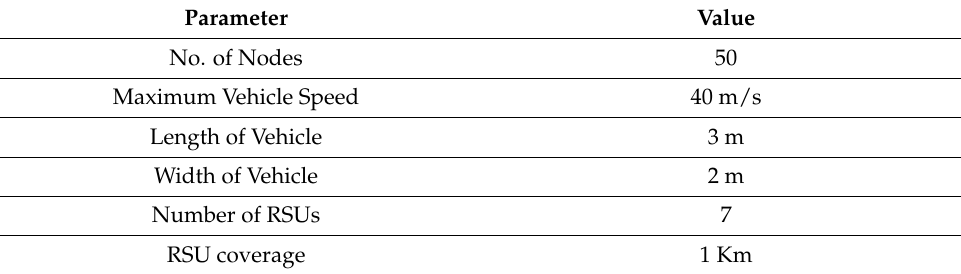
Table 1. Simulation